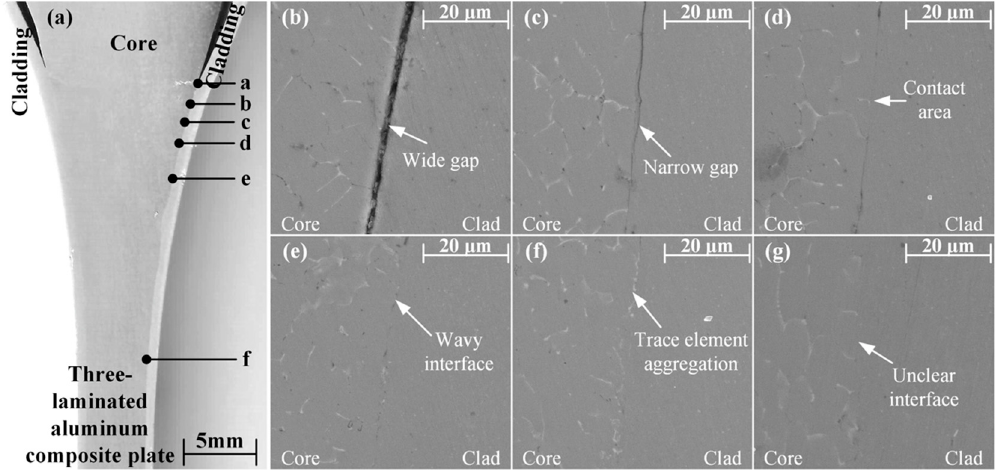
Figure 9. Evolution process of interface of SLS-TRC.